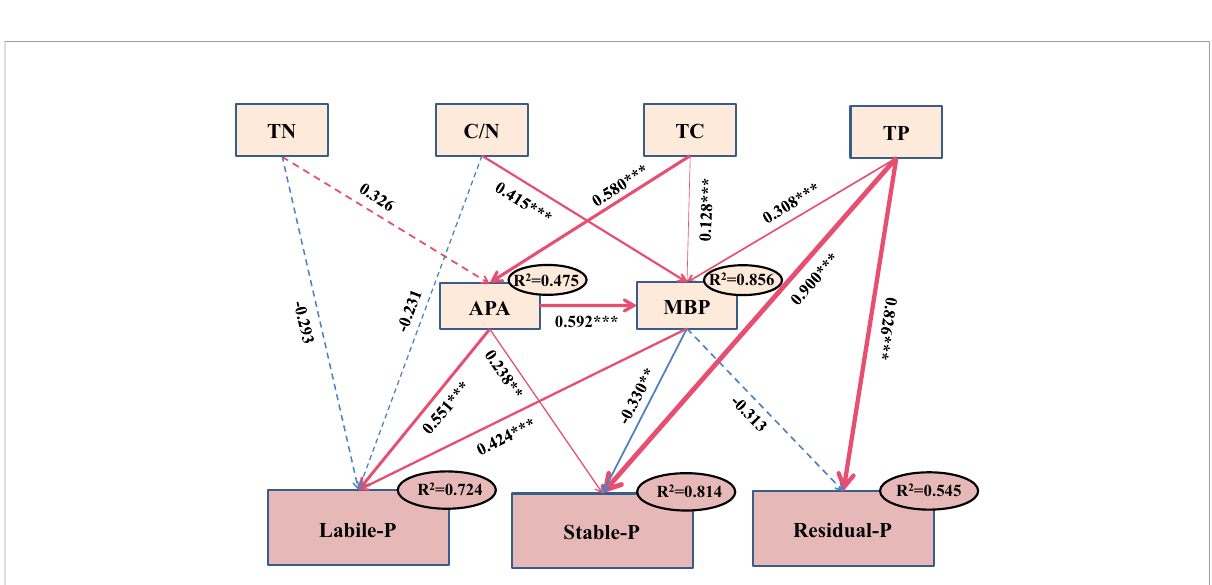
FIGURE 6 Structural equation modeling (SEM) analysis for effects of environmental factors on soil phosphorus (P) fractions in experiment 2. Goodness-of- fi t statistics for the model are as follows: c 2 = 0.569, p = 0.904, CFI = 1.000, RMSEA = 0.000, AIC = 1829.317. ** and *** indicate p < 0.01 and p < 0.001. Red and blue lines indicate positive and negative relationships, respectively. Arrows suggest the hypothesized direction of causation. Solid lines indicate signi fi cant pathways, whereas dashed lines indicate nonsigni fi cant pathways. The standardized path coef fi cients are indicated by values adjacent to the arrows. Arrow thickness is proportional to the relationship strength. R 2 values referred to the proportions of the observed variance; n = 108. Abbreviations: TP, total phosphorus; MBP, microbial biomass P; APA, acid phosphatase activity; TC, total carbon; TN, total nitrogen; C/N, total carbon/total nitrogen. Soil labile P refers to the fi rst component (PC1) from the principal component analysis (PCA) conducted for resin P, NaHCO 3 -P i , NaHCO 3 -P o , NaOH-P i , and NaOH-P o